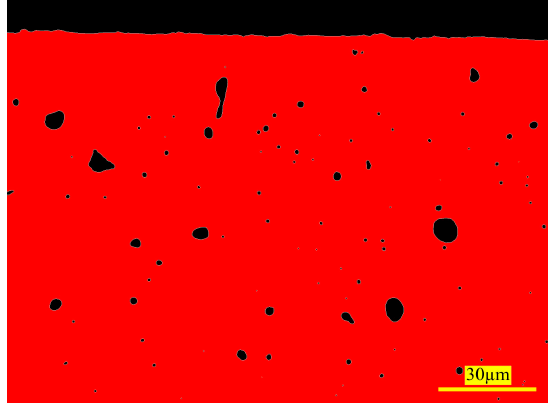
Figure 4. Optical images of porosities.